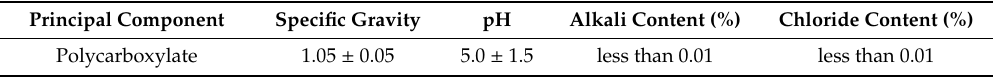
Table 3. Properties of polycarboxylate high-range water reducer (HRWR) [12,20].